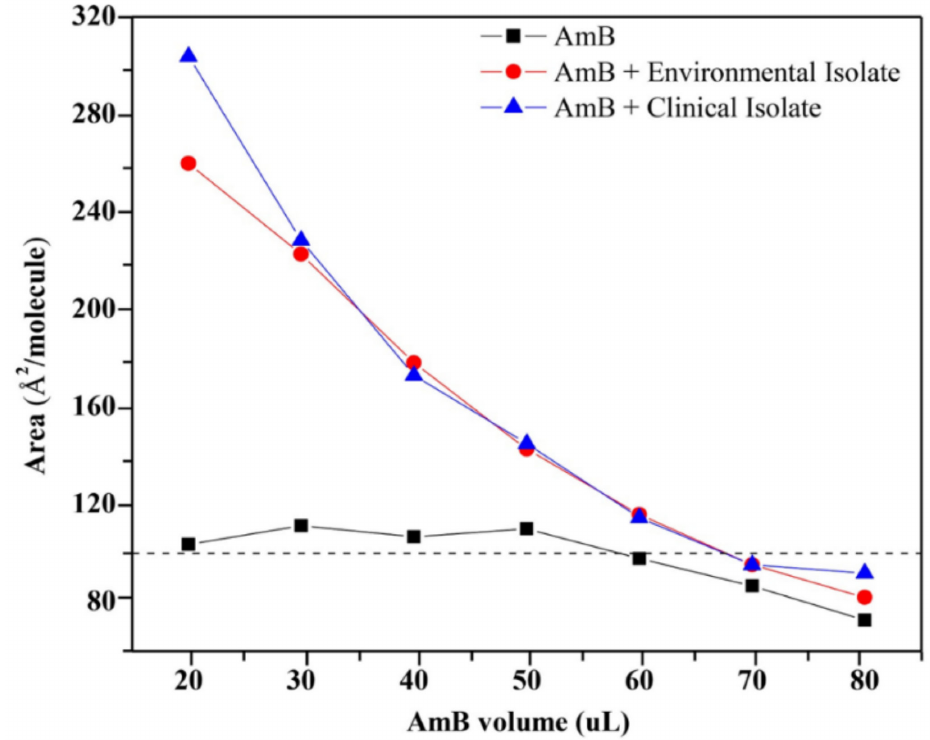
Figure 4. Effect of the volume of AmB on the area of the monolayers of lipids extracts associated to the external surface of the cell wall of the mycelial phase of H. capsulatum of the clinical (5 µ L) and environmental (5 µ L)